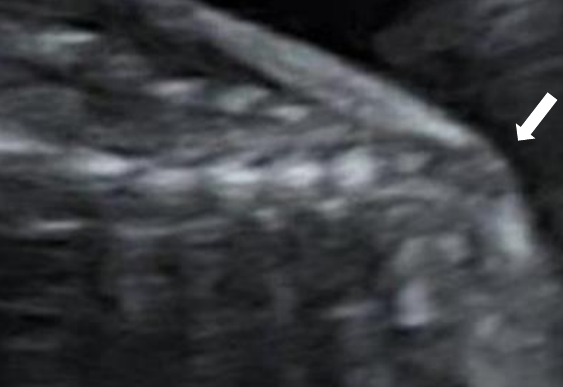
Figure 4. Minimal fistular connection between skin and spinal canal.